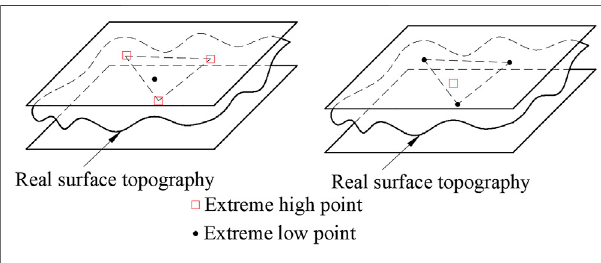
FIGURE 8 | Triangular